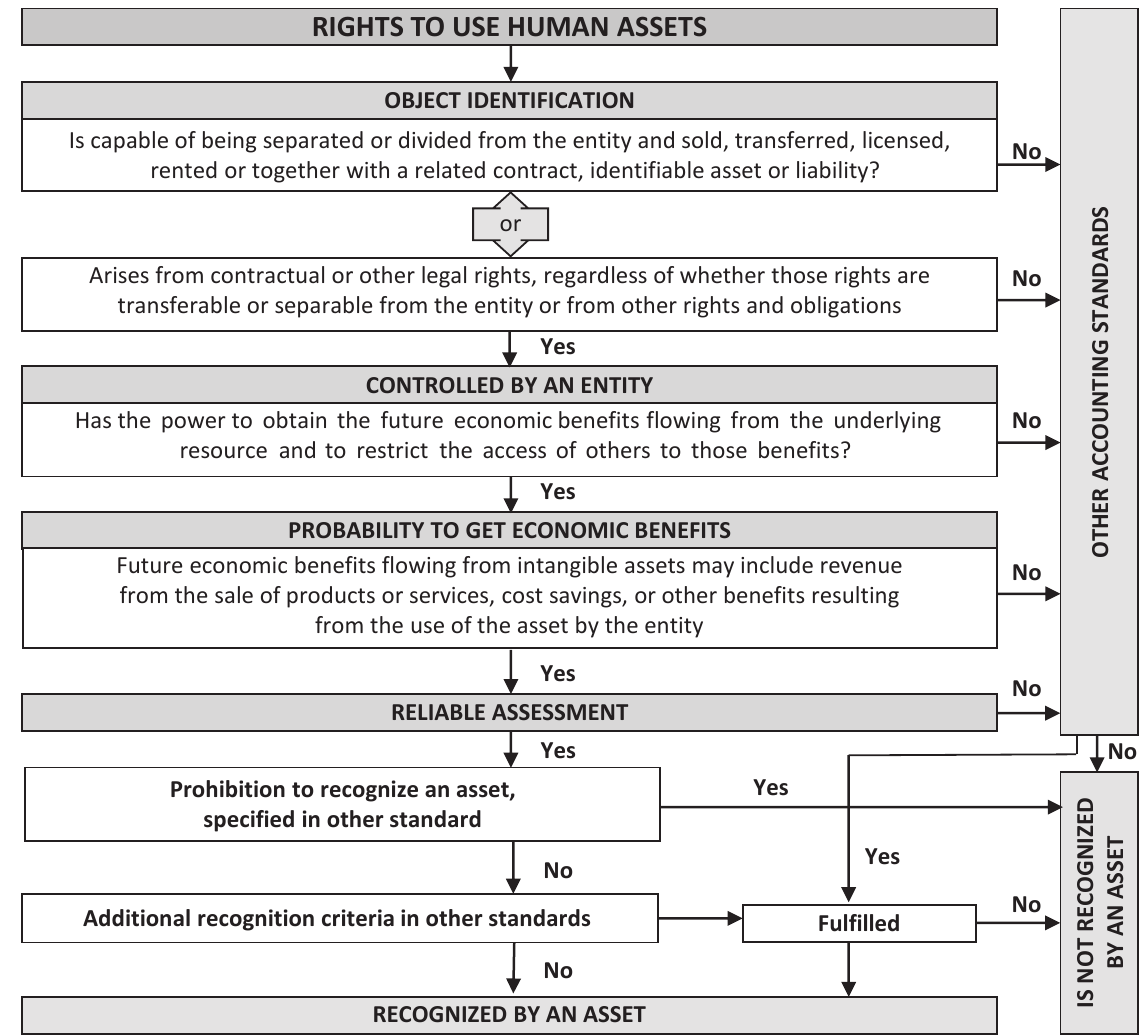
Figure 3. Algorithm of recognition of rights to use human assets as intangible